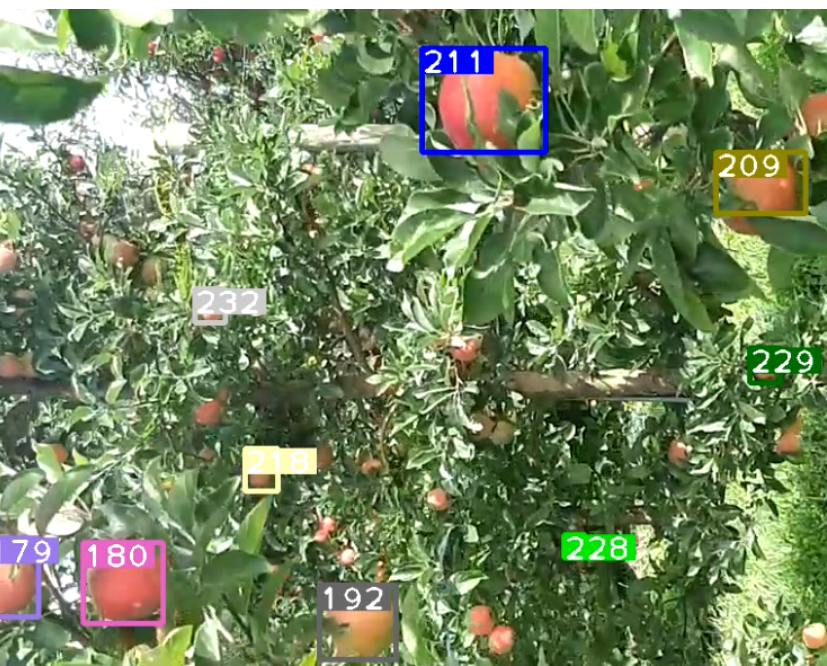
Figure 4. From the apple orchard video used, some apples from a back row tree are being detected and